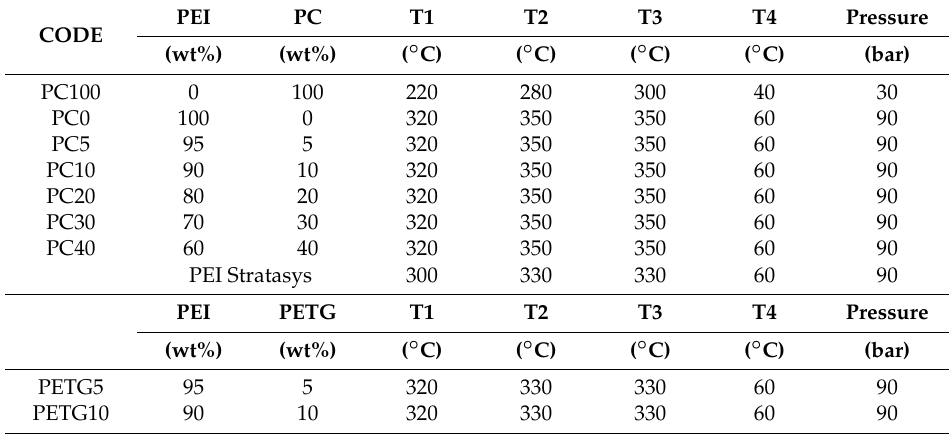
Table 1. Polymer blend ratios prepared by injection molding alongside with the parameters for